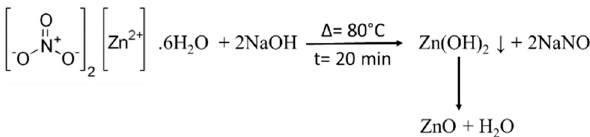
Figure B2. Schematic illustration of the synthesis process used. Here, the temperature of the synthesis was adjusted at 80 °C. When this temperature changes, the size and amount of ZnO NP change.